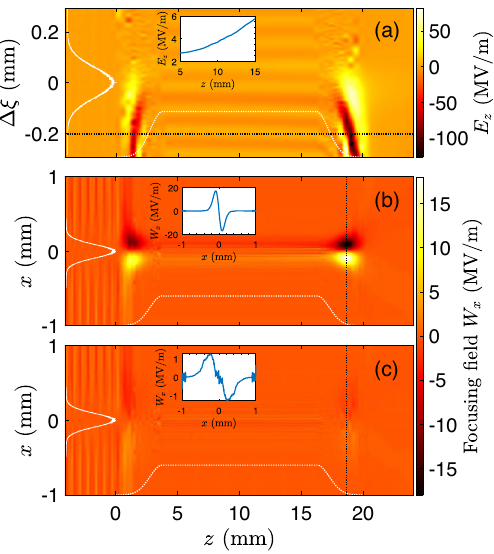
FIG. 6. Plasma wakefield obtained by the PIC simulation. (a) Longitudinal plasma wakefield E . The horizontal axis z z indicates the longitudinal coordinate of the APL, whereas the vertical axis Δ ξ represents the longitudinal coordinates of the electron beam slice. The electron beam head is placed at positive Δ ξ , whereas the tail is located at negative Δ ξ . Negative z indicates the drift space before the APL. The solid and dashed white lines are the longitudinal electron beam distribution and plasma density distribution along the APL, respectively. Both distribu- tions are given in arbitrary units. The inset in the figure shows the longitudinal wakefield at the black dotted line between 5 and 15 mm. (b – c) Horizontal plasma wakefield W captured at the x center of the electron beam longitudinal slice where the vertical FIG. 5. Maximum normalized E field generated by drive z axis x represents the horizontal electron beam coordinates. The proton (green) and witness electron (blue) beams along the solid white line is the horizontal electron beam distribution. The entrance region of the APL. The rms beam size and bunch insets in the figure show the horizontal wakefield at the black length of the proton (electron) beam used for this calculation are dotted lines. The initial electron beam sizes are (a,b) 100 221(100) and 107 ð 60 Þ μ m, respectively. Black dotted line and (c) 250 μ indicates the APL plasma density distribution in arbitrary units.